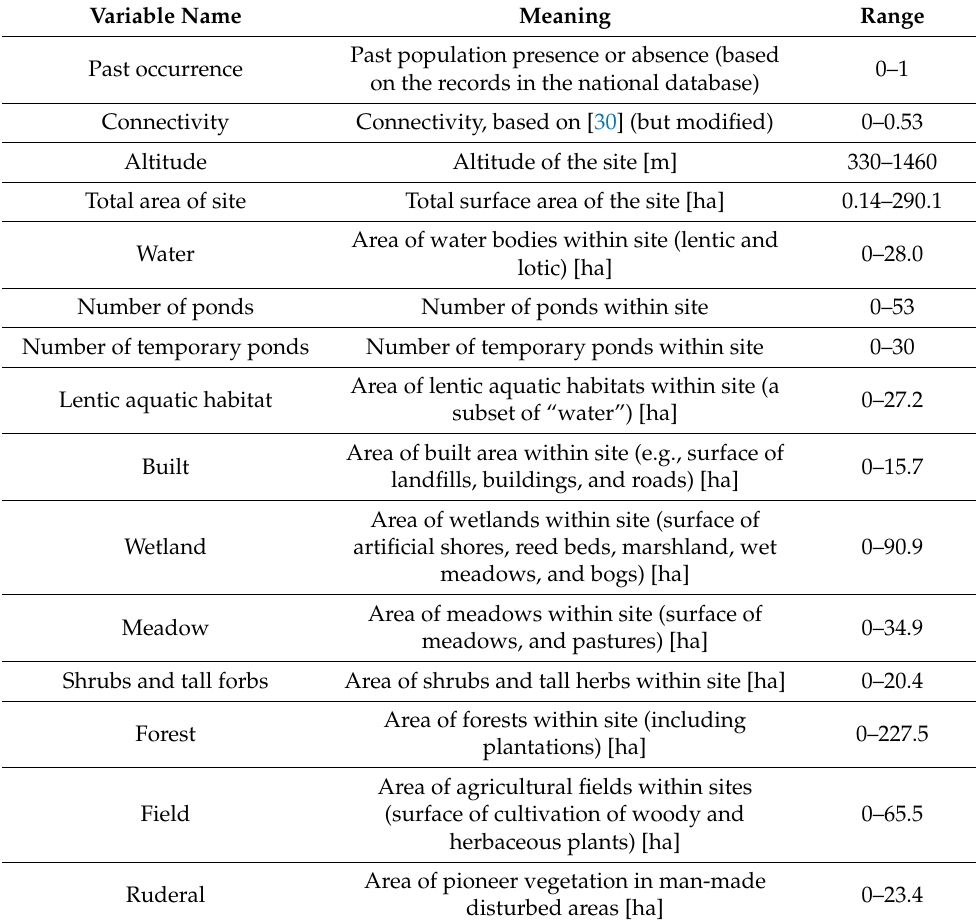
Table 1. Variables used in occupancy models. The habitat variables are based on an established classification of habitats in Switzerland [45]. For an example of a habitat map, see Figure 1. In the modelling, habitat types were used either as areas (in hectares) or as proportions (area of habitat type divided by total area of the site). Sites were protected amphibian breeding sites of national